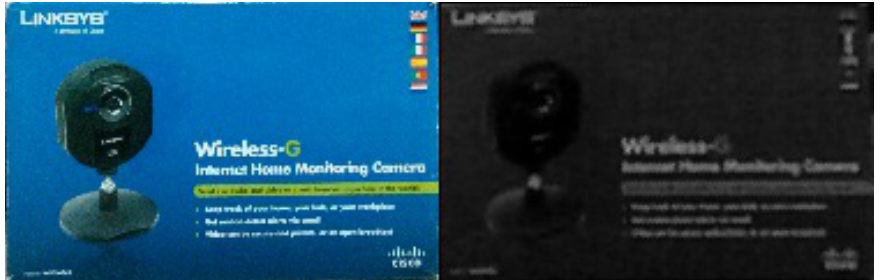
Figure 13. Experiment 1, Box.